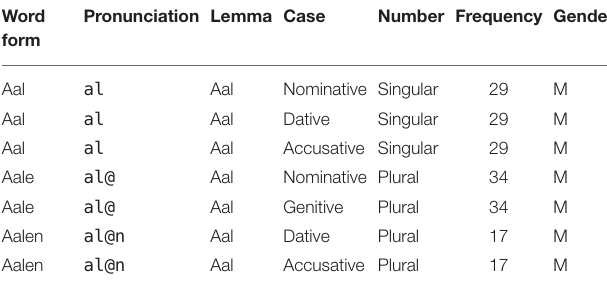
TABLE 3 | Representation of the paradigm for Aal “eel” in our